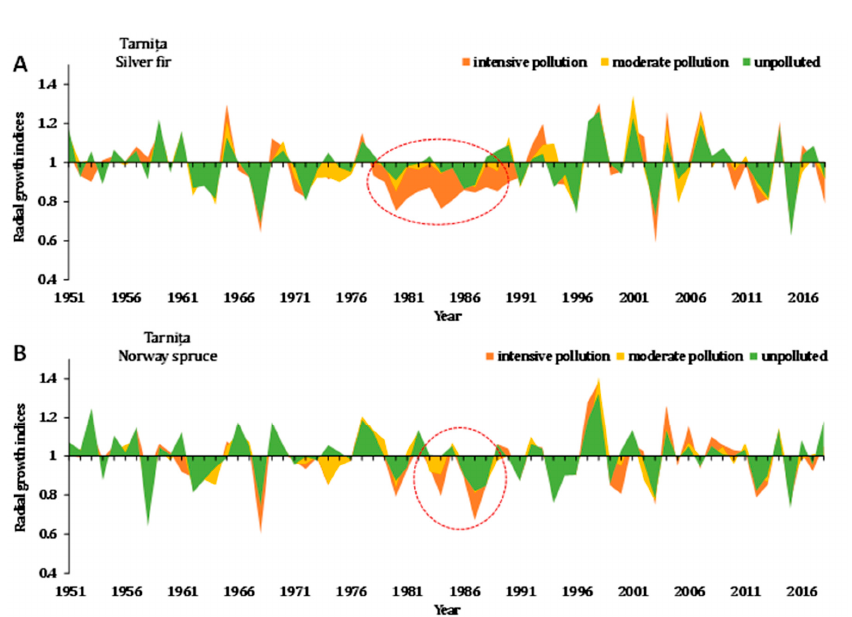
Figure 2. The average series of radial growth indices developed for each of the 3 categories of stands studied (the dotted circle represents the time interval in which the trees were most affected by air pollution); ( A ) silver fir; ( B ) Norway